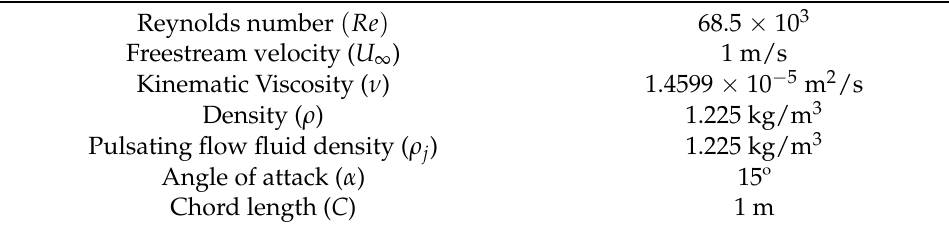
Figure 2. Sketch of the groove location and injection angle over the airfoil. Table 1. Physical